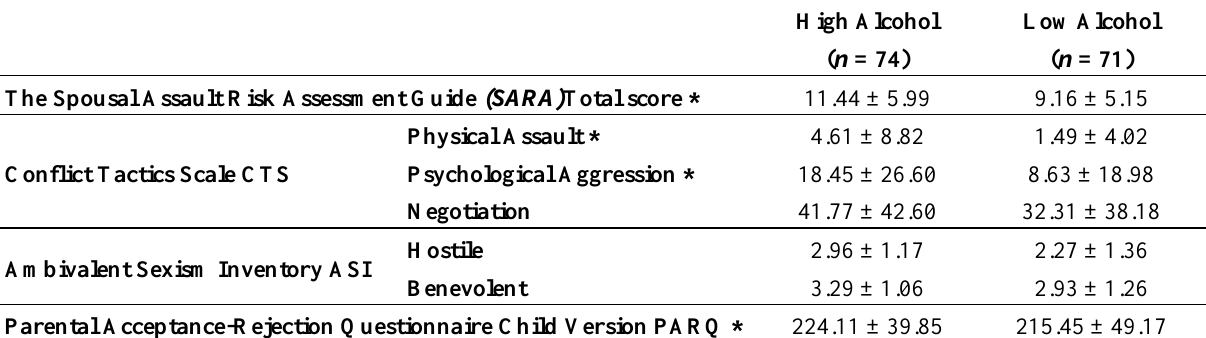
Table 2. Mean ± SEM of SARA, CTS, ASI, and PARQ for High Alcohol (HA) and Low Alcohol (LA) IPV perpetrators. * p <